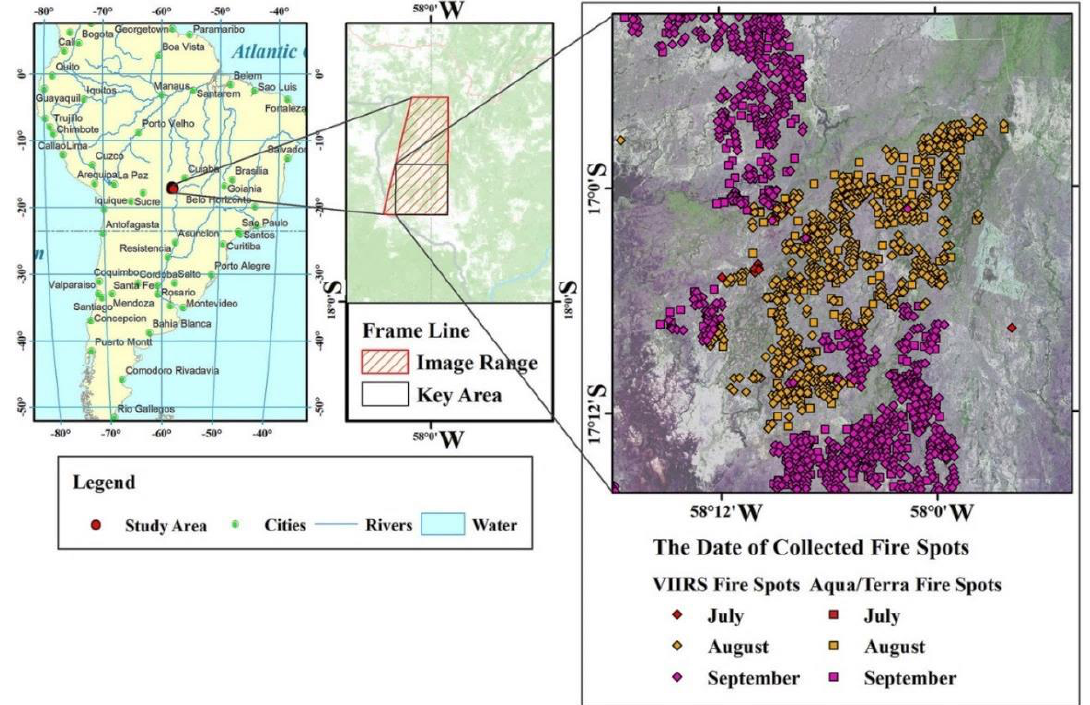
Figure 1. The distribution of fire sites in the Pantanal wetland. VIIRS: Visible Infrared Imaging Radiometer Suite.